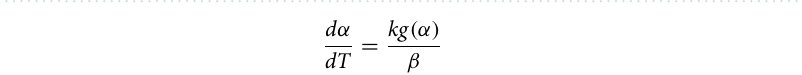
Table 5. Preexponential factors and activation energies under CO 2